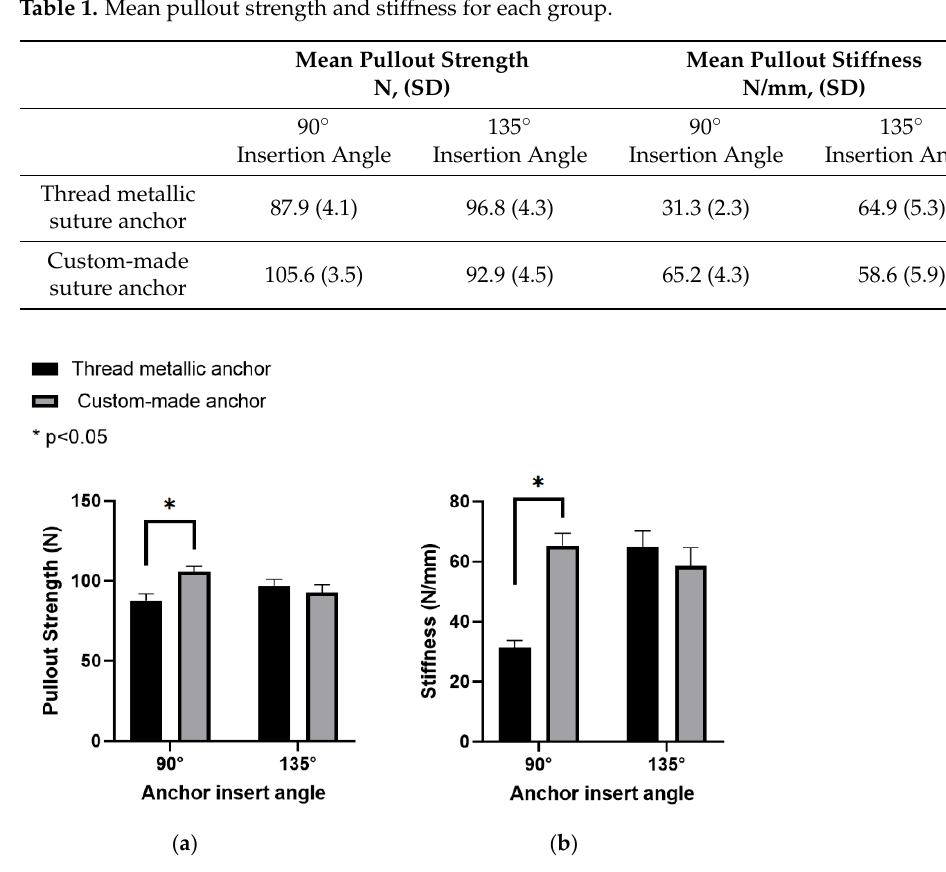
Figure 4. ( a ) Mean load to failure, showing a significant difference ( p < 0.05) between the groups with a 90° insertion angle.; ( b ) mean construct stiffness, showing a significant difference ( p < 0.05) between the groups with a 90° insertion angle. Table 1. Mean pullout strength and stiffness for each group.